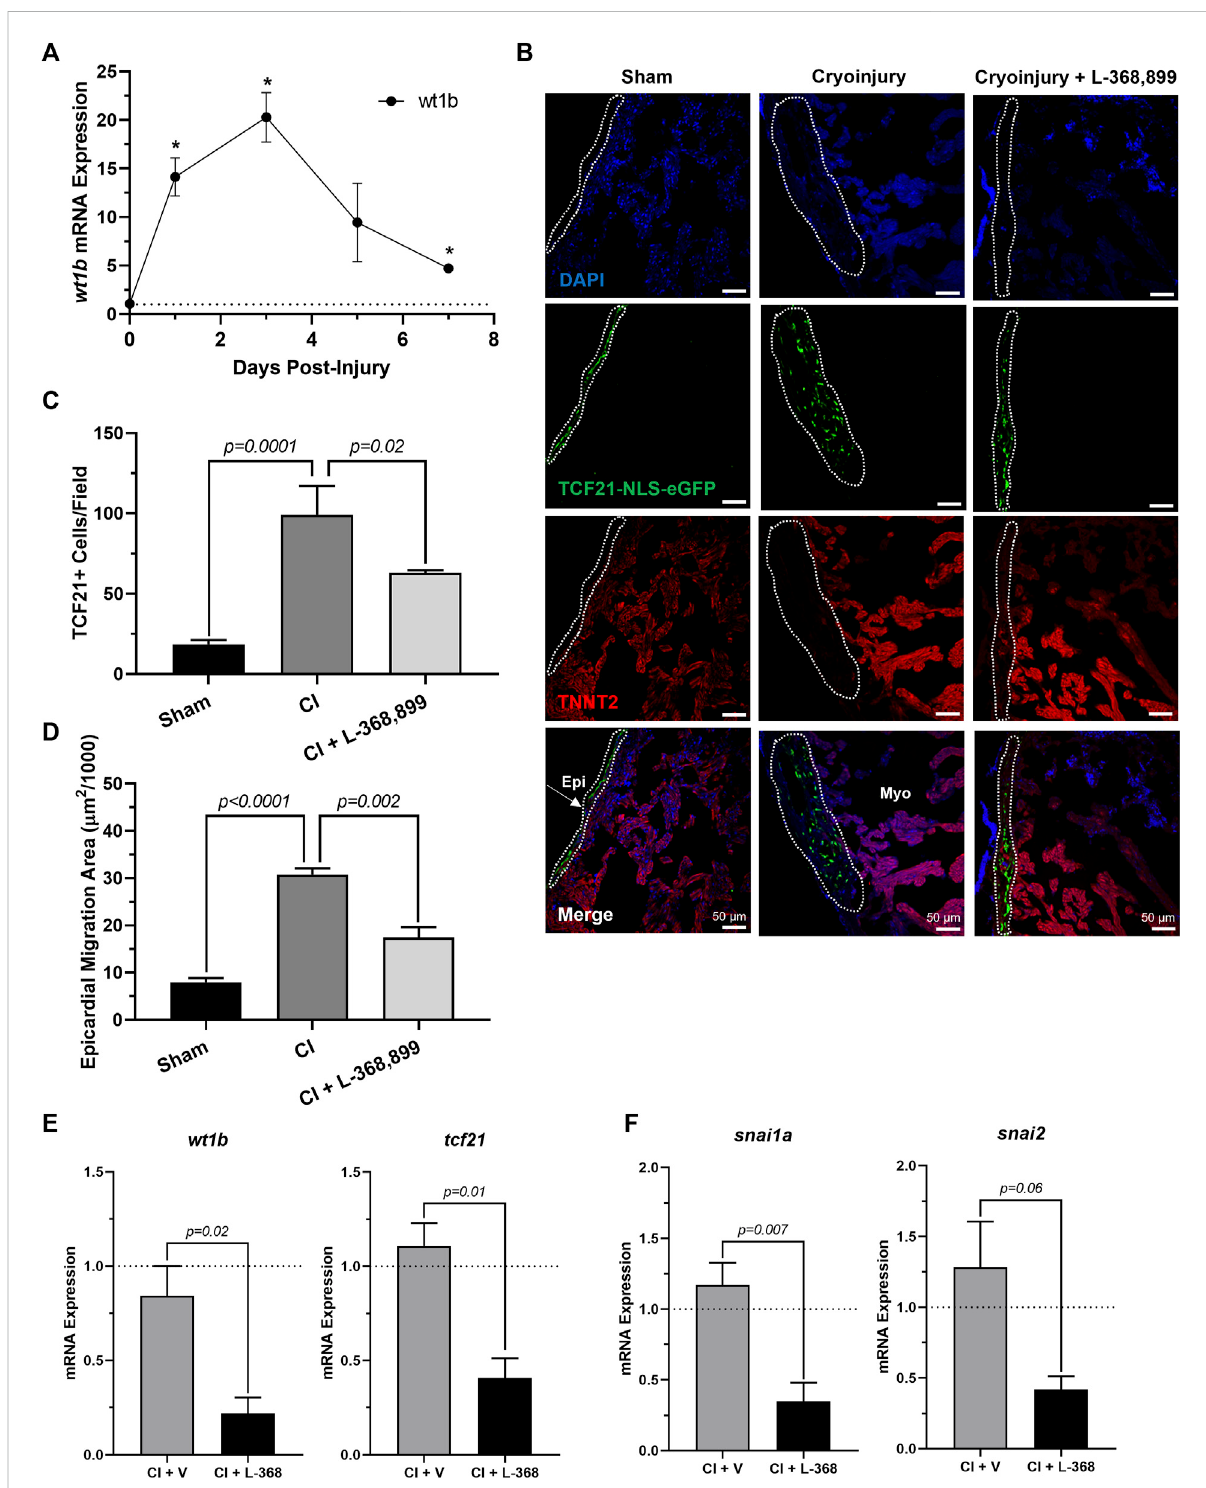
FIGURE 7 InhibitionofOxytocinSignalingPreventsEpicardialActivationAfterZebra fi shCardiacInjury. (A) TimecourseqRT-PCRdatafor wt1b inzebra fi sh hearts after cardiac cryoinjury; * p < 0.05 versus sham operated heart; n = 3 per time point. (B – D) Confocal immuno fl uorescent images (B) and quanti fi cation (C – D) of tcf21-nls-eGFP transgenic zebra fi sh at 3 dpi showing epicardial activation and expansion in sham, cryoinjured, and L- 368,899-treated hearts. In (B) , epicardial cell nuclei are labeled with GFP (green), cardiomyocytes are labeled with TNNT2 (red), nuclei are labeled with DAPI (blue); n = 3 – 5 images per condition, scale bar: 50 µm. (E – F) qRT-PCR data for wt1b and tcf21 (E) and snai1a and snai2 (F) in cryoinjured zebra fi sh hearts at 3 dpi treated with and without 1 µM L-368,899 (L-368); n = 3 – 5 per condition; CI: Cryoinjury, dpi: Days Post-Injury, Epi: Epicardium, Myo: Myocardium, V: